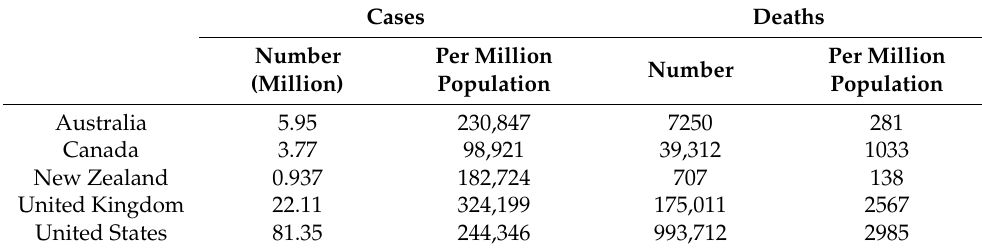
Table 1. COVID-19 total cases and deaths as of 30 April